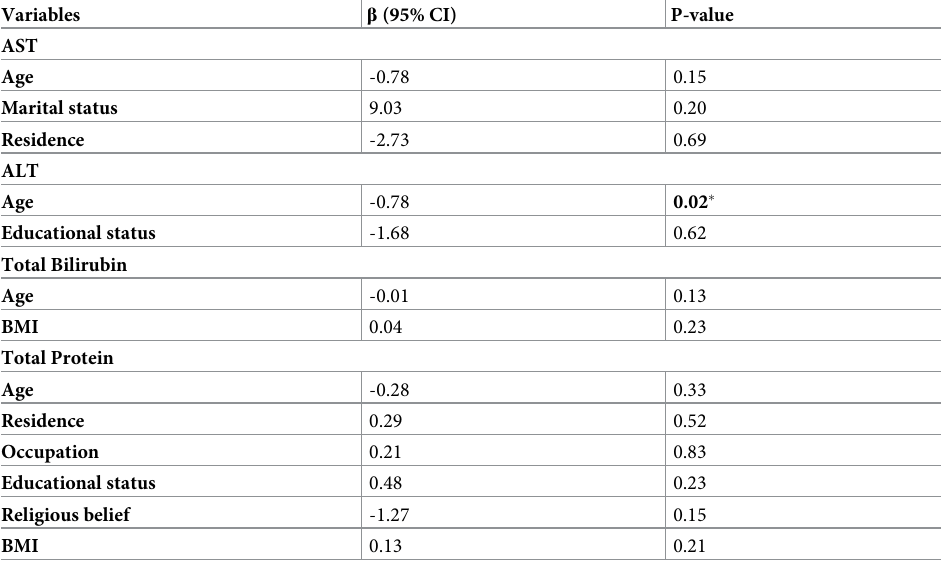
Table 11. Multiple linear regression analysis of ALT, AST, serum total bilirubin and serum total protein in VL patients. Variables